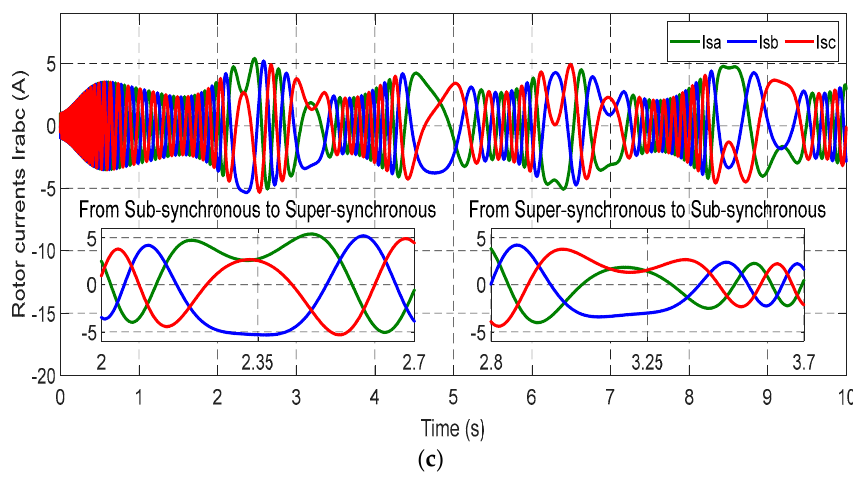
Figure 20. Rotor current i rabc , ( a ) DPC, ( b ) Backstepping control, and ( c ) DPC ‐ ANN.